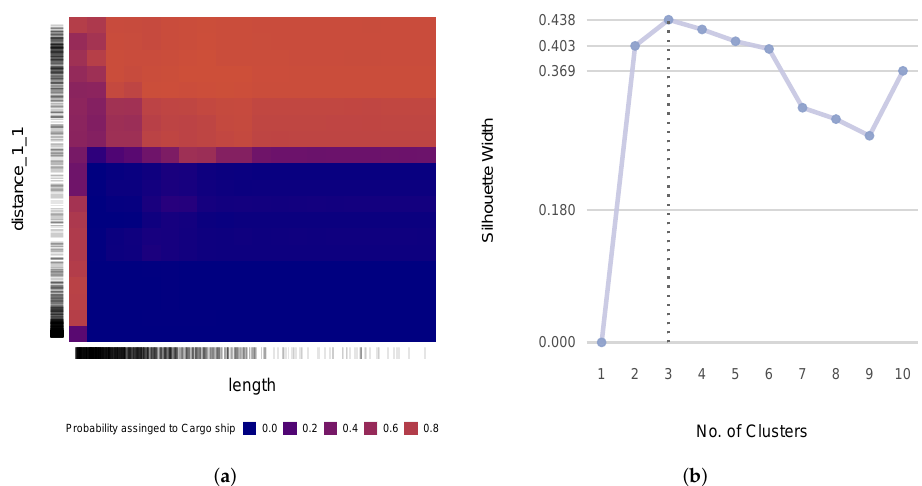
Figure 7. ( a ) The PDP of distance_1_1 and length for geometric descriptor-based models; ( b ) the silhouette scores from the different numbers of clusters for the kinematic descriptor-based